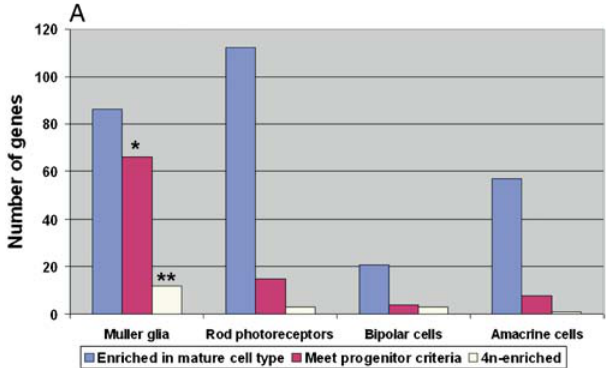
Figure 5. Mu¨ller-Glia-Enriched Genes (A) Mu¨ller-glia-enriched genes show stronger expression in retinal progenitors than do genes enriched in other postnatally born cell types. See Materials and Methods for details of how progenitor- enriched and cell-specific expression patterns were determined, and p -values for progenitor-enrichment of genes that are cell type– specific in the mature retina were calculated. Data on 4N-enriched transcripts were obtained from Livesey et al. (2004). Numbers for each value are as follows. For N, the number of cell-enriched genes, N MG = 86, N Pr = 112, N BC = 21, and N AC = 57. For I, the number of genes that show retinal progenitor-enriched patterns by ISH, I total = 180, I MG = 66, I PR = 15, I BC = 4, and I AC = 8. For M, the number of genes enriched in 4N retinal progenitor cells that were tested by ISH in adult retina, M total = 28, M MG = 12, M PR = 3, M BC = 3, and M AC = 1. *, p , 10 (cid:1) 13 ; **, p , 0.0001. (B) Mu¨ller-glia-enriched genes show strong expression in mitotic progenitors. The genes shown are: Mm.26062/ADO24, Mm.55143/Dkk3, Mm.5021/DDR1, Mm.35817, Mm.20465/GPCR37, Mm.200608/clusterin, and Mm.22288/cyclin D1 . Sections were from central retina. Cellular laminae of both the developing and mature retina are indicated with colored bars. All pictures were taken at 200x. See Table S5 for a full list of probes used. (C) Dynamic expression of metabolic genes in developing retina. Metabolic enzymes are often selectively expressed in mitotic progenitors and developing Mu¨ller glia. The genes shown are Mm.27953/glycine decarboxylase, Mm.9114/mu-crystallin, and Mm.213213/ HK-R . Cellular laminae of both the developing and mature retina are indicated with colored bars. Sections were from central retina. All pictures were taken at 200x. See Table S5 for a full list of probes